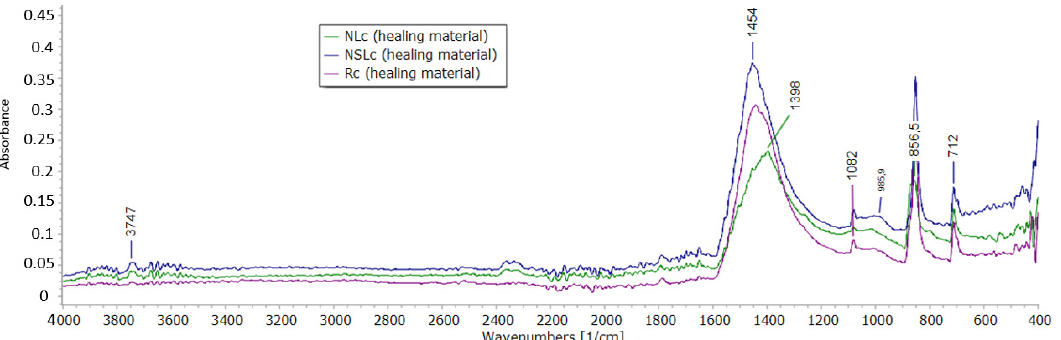
Figure 8. ATR spectra of the healing material obtained from the crack of the samples cured in water immersion.